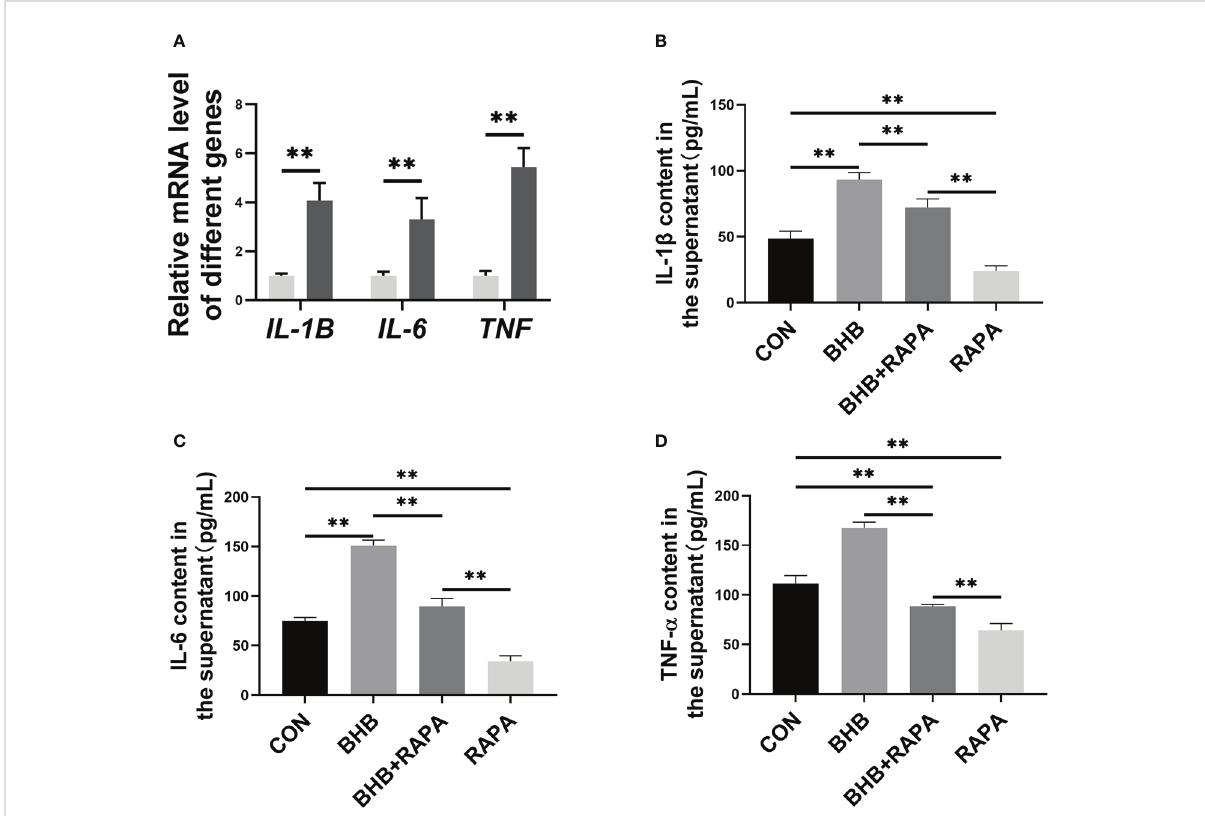
FIGURE 6 Role of autophagy in BHB promoting the production of pro-in fl ammatory factors in bovine neutrophils. Neutrophils were treated with 1.6 m M BHB for 2 h. (A) mRNA abundance of IL-1B and IL-6 , and TNF . For qRT-PCR experiments, b -Actin and YWHAZ were used to normalize mRNA abundance. Data were expressed as the mean ± SEM. Data were analyzed with independent-sample t-tests. (B-D) Rapamycin (100 n M , 2 h ) was used to activate autophagy. The concentration of IL-1 b , IL-6, and TNF- a in the supernatant of the medium. Data were expressed as the mean ± SEM. A two-way analysis of variance (ANOVA) was performed to analyze differences between BHB and RARA, including a Bonferroni post-hoc analysis. Two-way ANOVA showed a signi fi cant difference in BHB × RAPA interaction ( P < 0.01), including a Bonferroni post-hoc analysis. ** P < 0.01 as statistically highly signi fi cant. CON, control; BHB, b -hydroxybutyrate; RAPA, rapamycin; IL, Interleukin; TNF- a , Tumor necrosis factor- a ; SEM, standard error of the